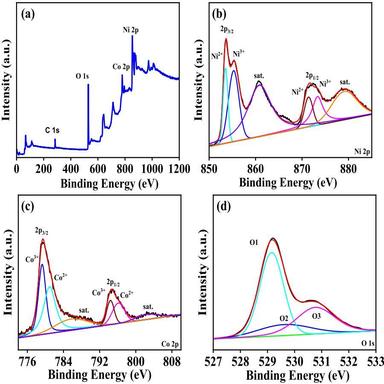
XPS of the NCO-25 sample with (a) survey spectra and (b) high-resolution Ni 2p, (c) Co 2p, and (d) O 1 s spectra.